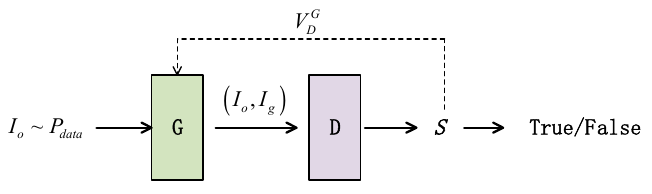
Figure 2. The framework of InsulatorGAN.